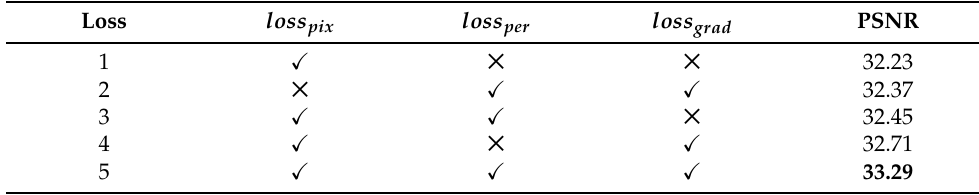
Table 1. Test of different loss on the Set5